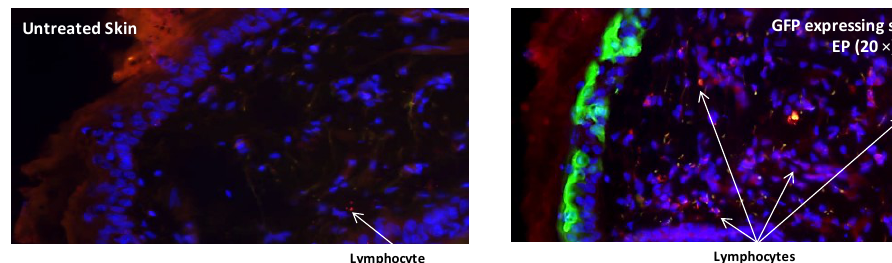
Figure 5. Histological analysis reveals infiltration of lymphocytes at the EP treatment site . Guinea pig skin sections were immunohistochemically stained with an antibody recognizing lymphocytes and Langerhans cells (Tetramethylrhodamine isothiocyanate ( TRITC) secondary) after ID GFP plasmid administration followed by EP with SEP. Skin biopsies were removed, cryosectioned, antibody and 4',6-diamidino-2-phenylindole ( DAPI) stained and visualized under fluorescence microscopy at 20× and 40×. An untreated control (no DNA, no EP) is also